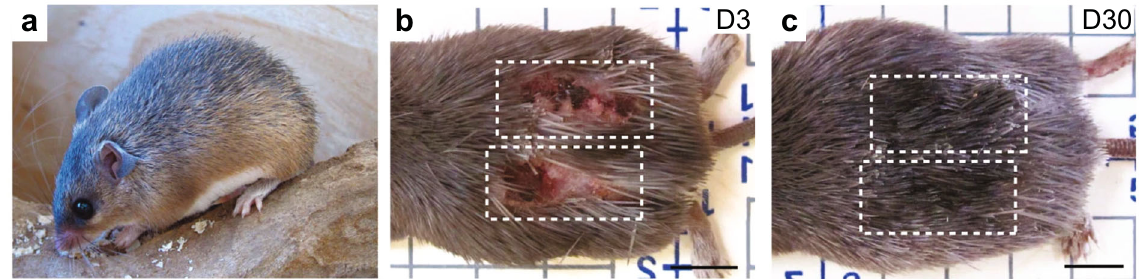
Fig. 1 Skin wounds heal and hairs regrow completely in Acomys . Acomys kempi ( a ) rapidly form scabs after full-thickness skin injury at day 3 (D3, b ), and the same wounds are concealed with new skin and spiny hairs at day 30 (D30, c ) Scale bars, 1 cm. Image adapted from Seifert et al. 3 with